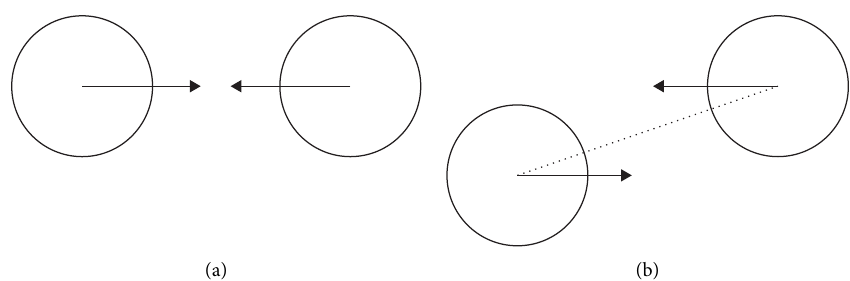
Figure 1: Diagram of (a) center-to-center collision and (b) of-center collision.